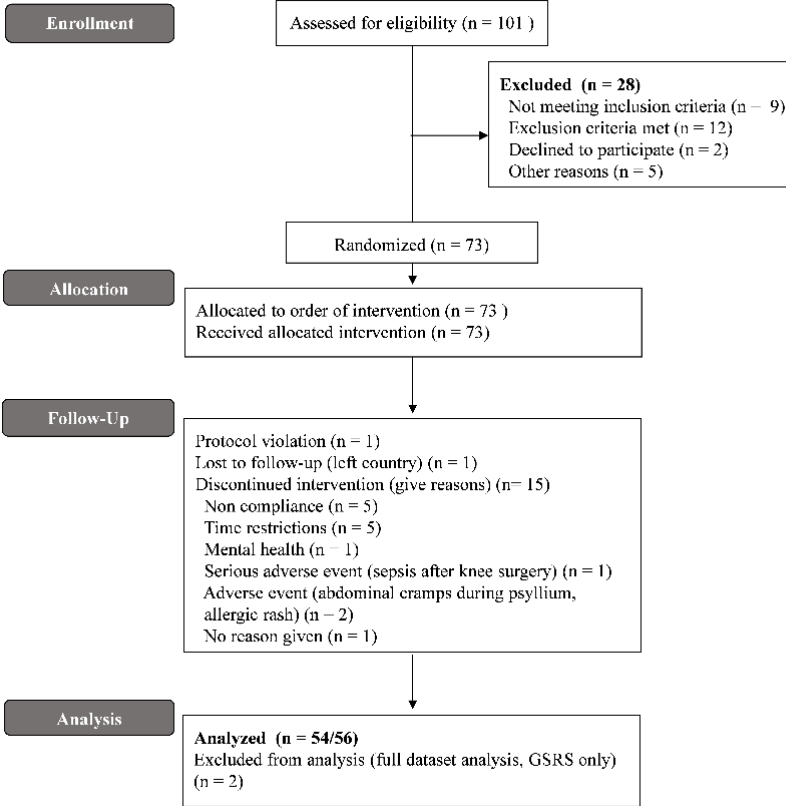
Figure 2. CONSORT flow diagram. Table 2. Baseline subject characteristics and IBS Symptom Severity Index (IBS-SSI).